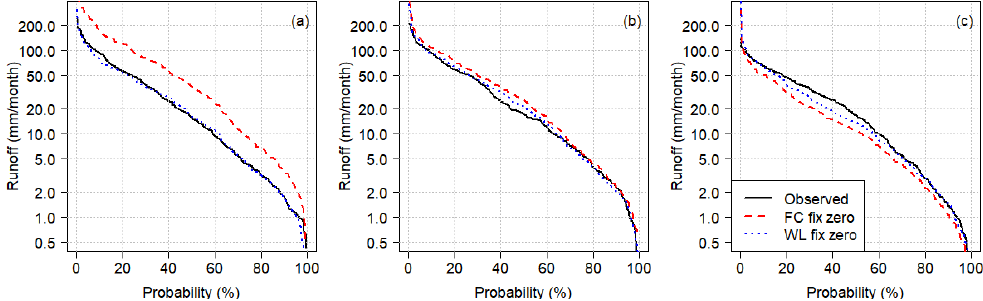
Figure 8. Effect of land use change and water licenses in Flow Duration Curves of Santa Lucía at Paso Pache ( a ), Fray Marcos ( b ), and Paso de los Troncos ( c